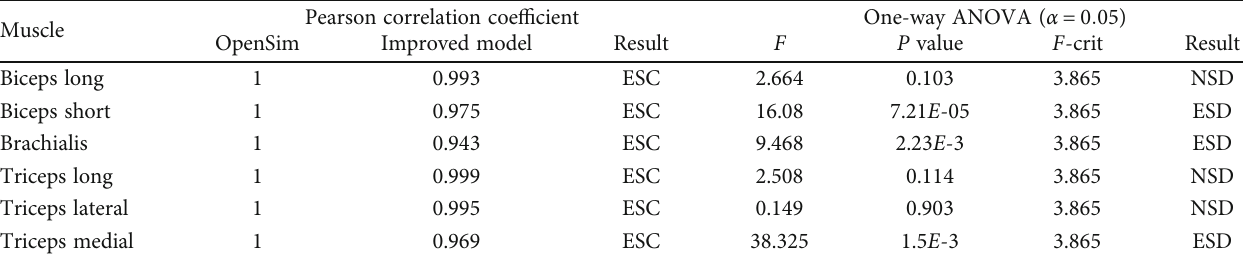
Table 4: Comparative analysis results of muscle force-time relationship.